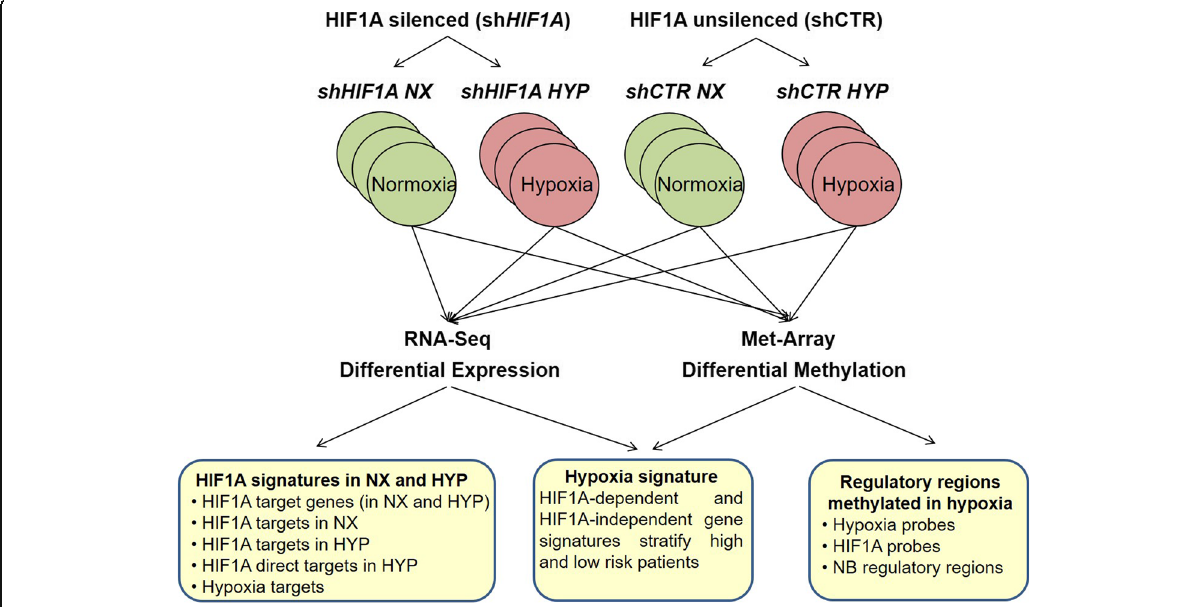
Fig. 5 Transcription activity of HIF1A in normoxia and hypoxia conditions. To investigate the transcription activity of HIF1A in normoxia and hypoxia conditions RNA sequencing and DNA methylation experiments were performed on NB cells silenced or unsilenced for HIF1A expression. Experimental points were used in triplicate. Analysis of gene signatures and hypoxia affected regulatory regions was performed as